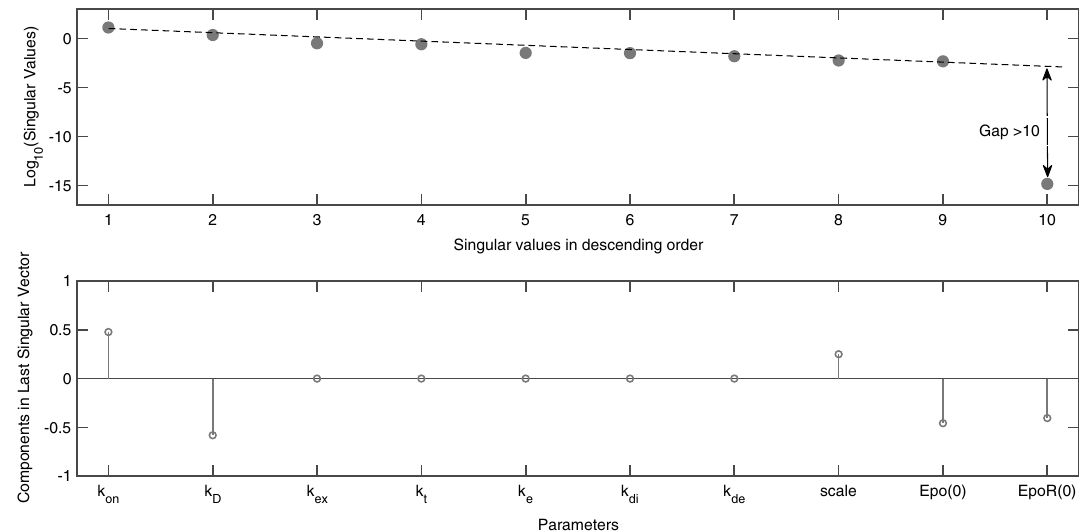
Figure 3. Identifiability signature of the Erythropoietin (Epo) and Epo receptor (EpoR) model ( M 3 ). (Top) Singular values: When output y = { y 1 , y 2 } is measured, and for the values defined in Eq. (20), with both [ Epo ] (0), [ EpoR ](0) nonzero. The clear gap between the spectrum of singular values suggests that the model is not structurally identifiable. (Bottom) Entries in the last column of the V matrix related to the singular value beyond the gap: Nonzero entries indicate that parameters k on , k D , scale , [ Epo ](0) and [ EpoR ](0) are structurally unidentifiable and apparently totally correlated. Experimental